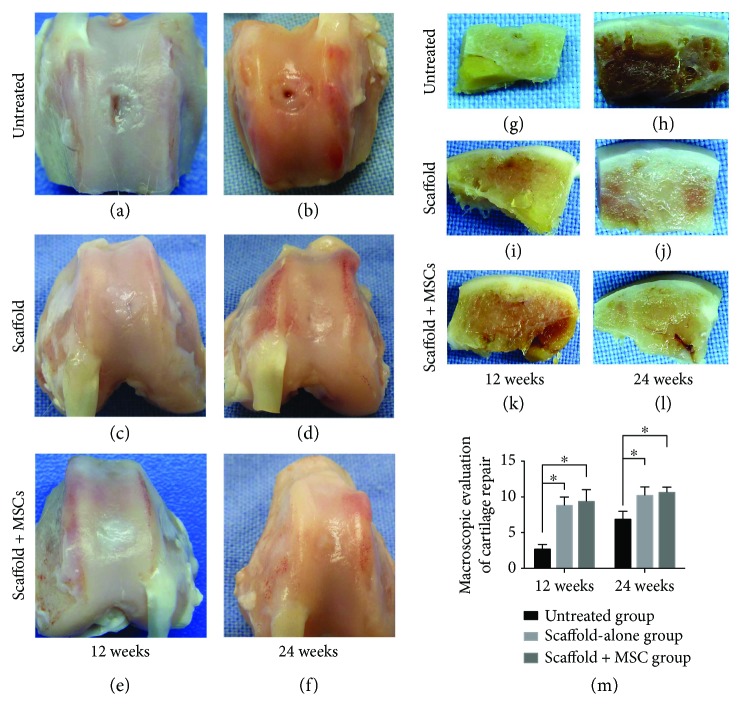
Gross appearance of regenerated cartilage at 12 and 24 weeks postoperation (a–f). Cross-sectional appearance of regenerated cartilage at 12 and 24 weeks postimplantation (g–l). Macroscopic examination and grading of regenerated articular cartilage revealed that the scores for the scaffold-alone and cell-loaded scaffold groups were better than those for the untreated group at 12 and 24 weeks (m). ∗P < 0.05.